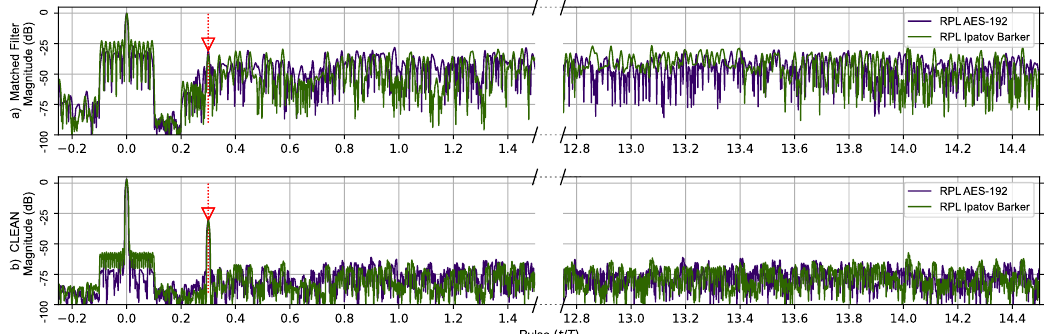
Figure 6. RPL AES-192 method (Purple) and RPL Ipatov–Barker method (Green) matched filter’s response for 78 simulated pulses. ( a ) Top, matched filter’s response before CLEAN. ( b ) Bottom, CLEAN reconstructed matched filter’s response when applied to both targets. The side lobes of the virtual target at zero eclipse the second target until CLEAN is used to reduce